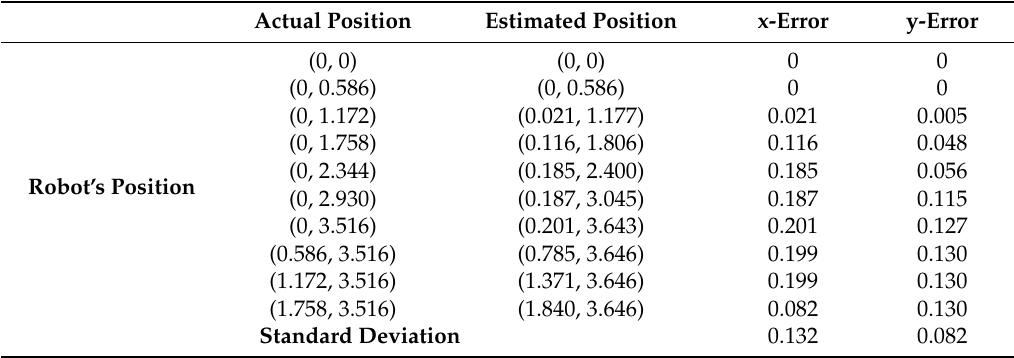
Table 3. Localization results of a mobile robot. X-error: the error of the robot’s positioning in the x -axis direction. Y-error: the error of the robot’s positioning in the y -axis direction.